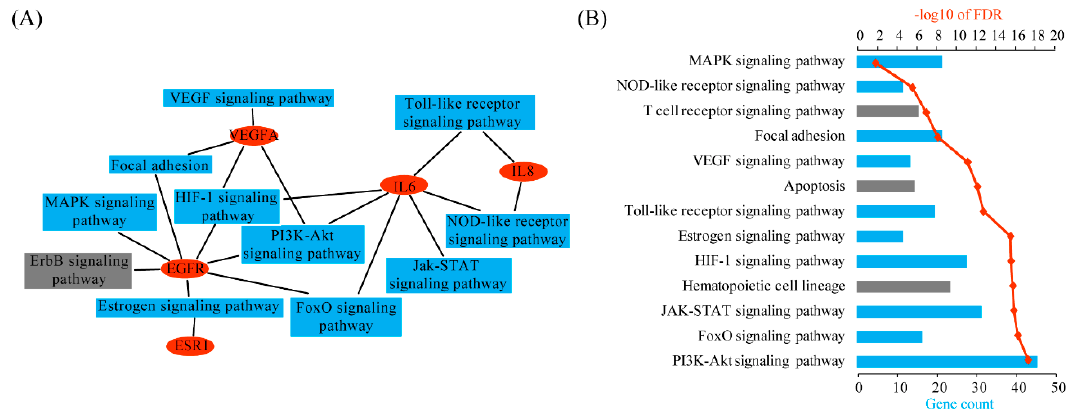
Figure 4. Pathway analysis. ( A ) Pathway assignment for the top five genes recommended by the TM-rank algorithm. This graph was generated by using the Cytoscape software. Ellipse nodes in red represent genes and rectangle nodes in blue represent pathways; ( B ) Pathway enrichment analysis for all the 264 genes identified by text mining. This analysis was performed by using the DAVID tool. The significance cutoff for FDR was set at